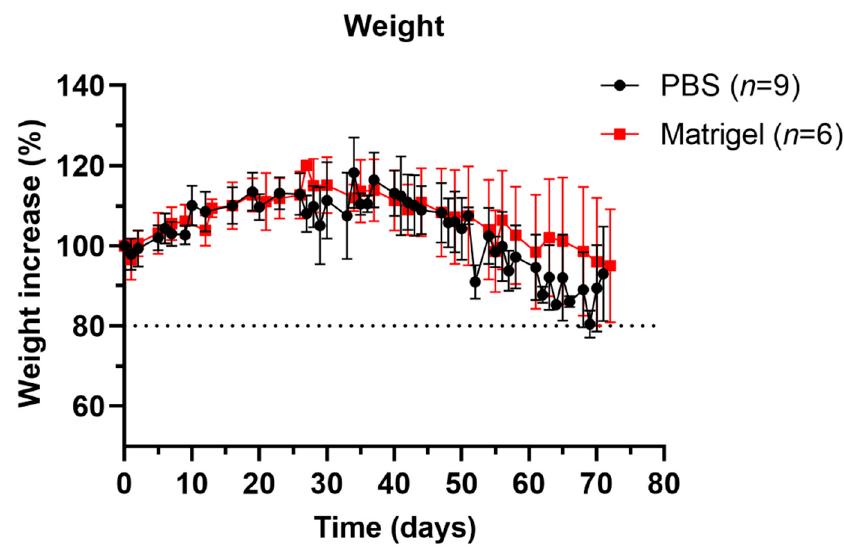
Figure 1. Weight profiles of mice inoculated with HSJD-DIPG-007 cells suspended either in PBS or Matrigel. Changes in weight after intracranial implantation of HSJD-DIPG-007 cells suspended in either PBS or Matrigel were monitored. Weight increased consistently up to day 37 for PBS and day 30 for Matrigel suspension groups, after which weight loss set in, lasting until terminal endpoint. No significant differences between PBS and Matrigel groups were observed. Dotted line represents the weight threshold of the humane endpoint. Data points are expressed as mean weight ± SD.